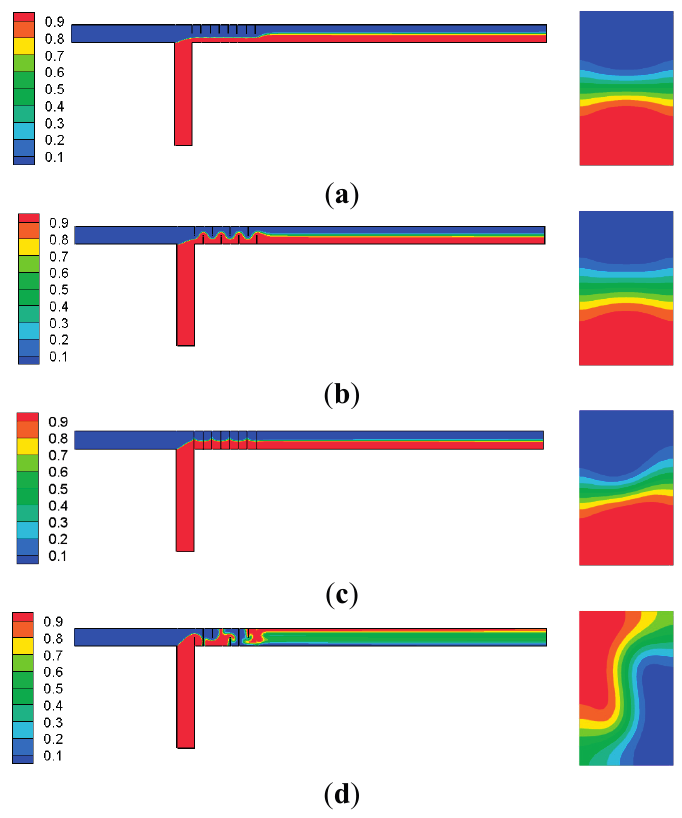
Figure 5. Comparison of the mass fraction contours of fluid “B” along the central plane. ( a ) Upper wall attachment. ( b ) Opposite wall attachment: type 1. ( c ) Opposite wall attachment: type 2. ( d ) Cyclic